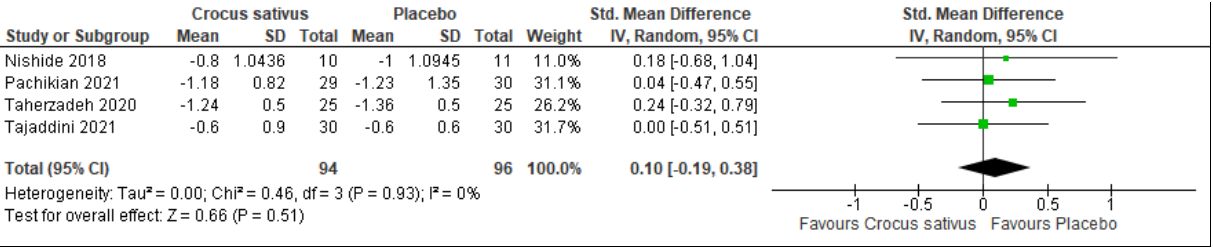
Figure 7. Forest plot for the outcome sleep duration [26,27,29 – 31]. Note: Line indicates confidence interval and the green square indicates effect estimate. Black diamond indicates cumulative effect estimate and its confidence interval. 3.6. Sleep Efficiency There was no difference in sleep efficiency between the Crocus sativus groups and the placebo groups in 5 trials (SMD: 0.08; 95%CI: −0.18 to 0.34; I 2 statistic = 0%; p = 0.54; 5 studies; 233 participants, low-quality evidence) [24,27,29 – 31] (Figure 8, Table 2). Figure 8. Forest plot for the outcome sleep efficiency [24,27,29 – 31]. Note: Line indicates confidence interval and the green square indicates effect estimate. Black diamond indicates cumulative effect estimate and its confidence interval. 3.7. Sleep Disturbances